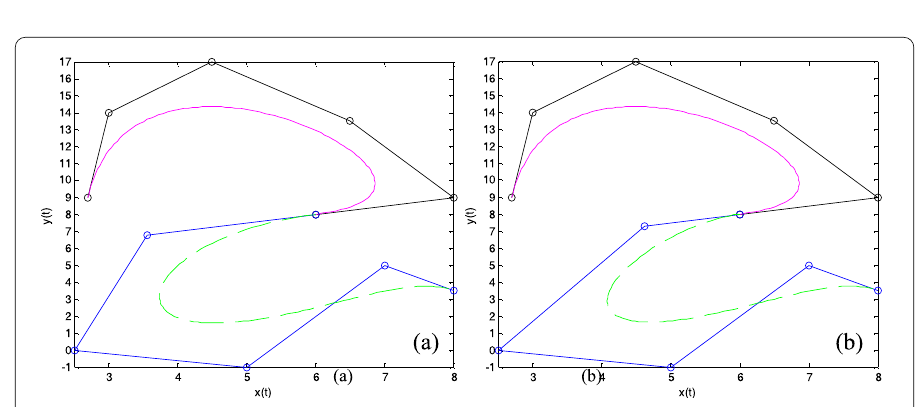
Figure 2 G 1 smooth continuity of Q-Bézier curves.